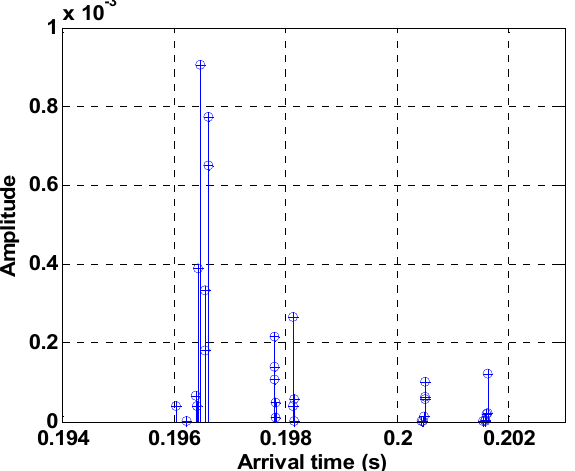
Figure 10. Channel impulse response for simulation.